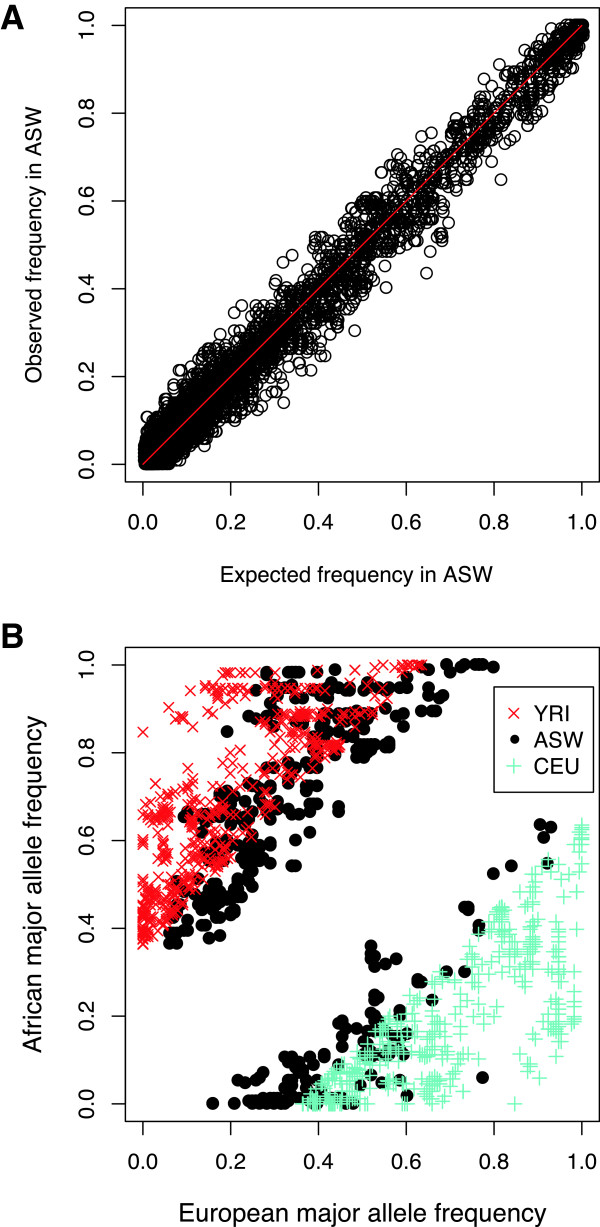
Allele frequency patterns of 32ADME core genes in African Americans. (A) A scatter plot of observed vs. expected allele frequencies of 32 ADME core genes in African Americans. (B) The allele frequency distribution of 806 highly differential SNPs (a frequency difference larger than 0.37 between at least two populations) among the three populations.